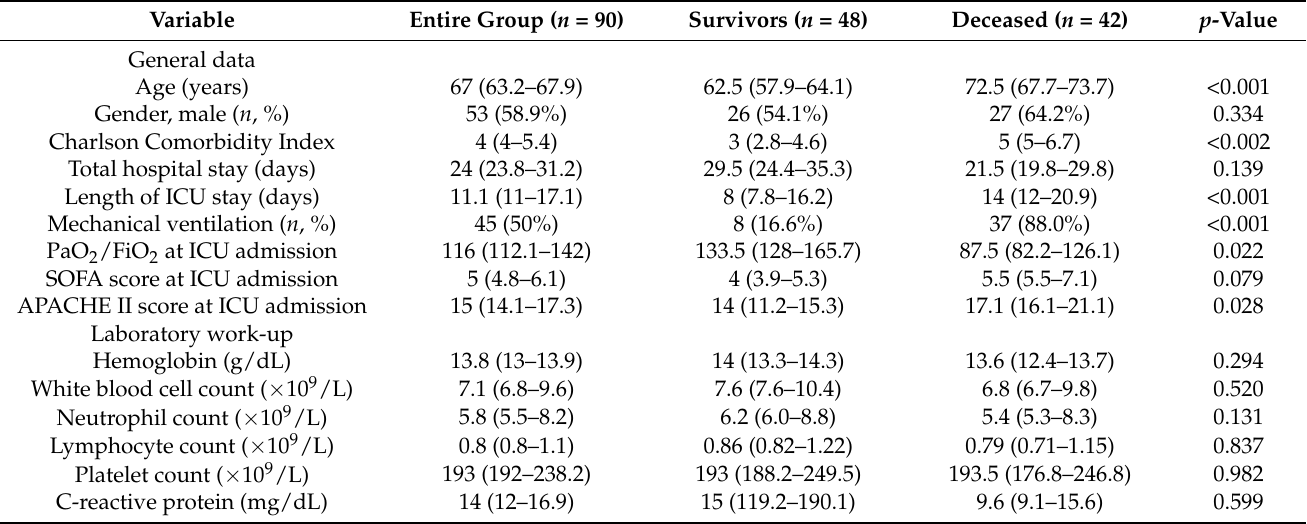
Table 2. Baseline characteristics of the study population and comparison between groups based on survivor